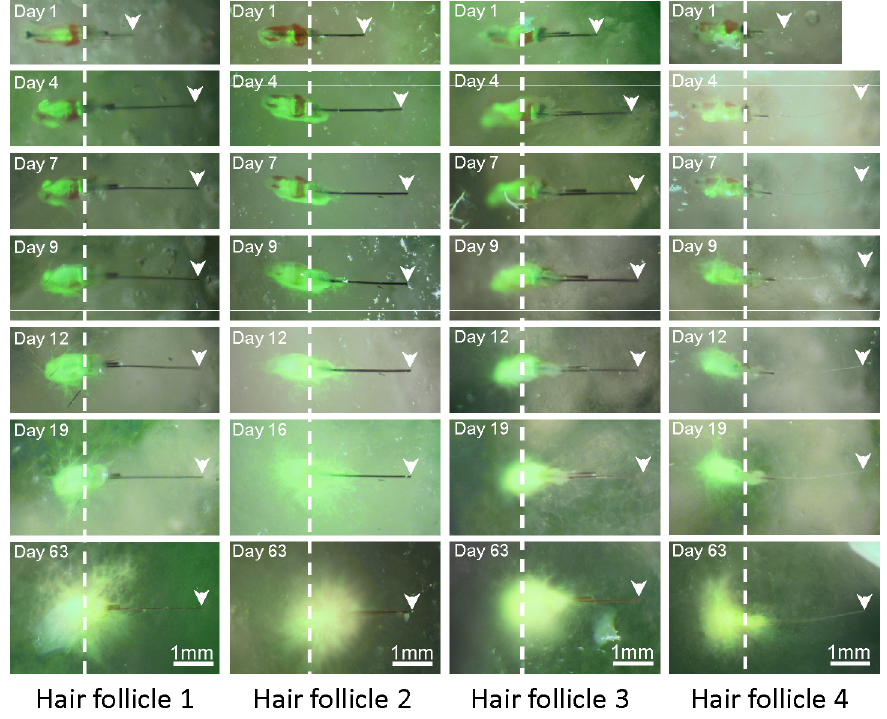
Fig 1. Hair shaft elongation of mouse whiskers in Gelfoam 1 histoculture. Time-course images of hair shaft growth from individual mouse whisker follicles, isolated from nestin-driven green fluorescent protein (ND-GFP) mice, histocultured on Gelfoam 1 . Green fluorescence was from the ND-GFP-expressing stem cells in the whisker hair follicles which were enriched during 63 days of histoculture in vitro . Hair shafts lengthened rapidly in the first 4 days, extended over 9 – 12 days, and remained the same length until day 63.